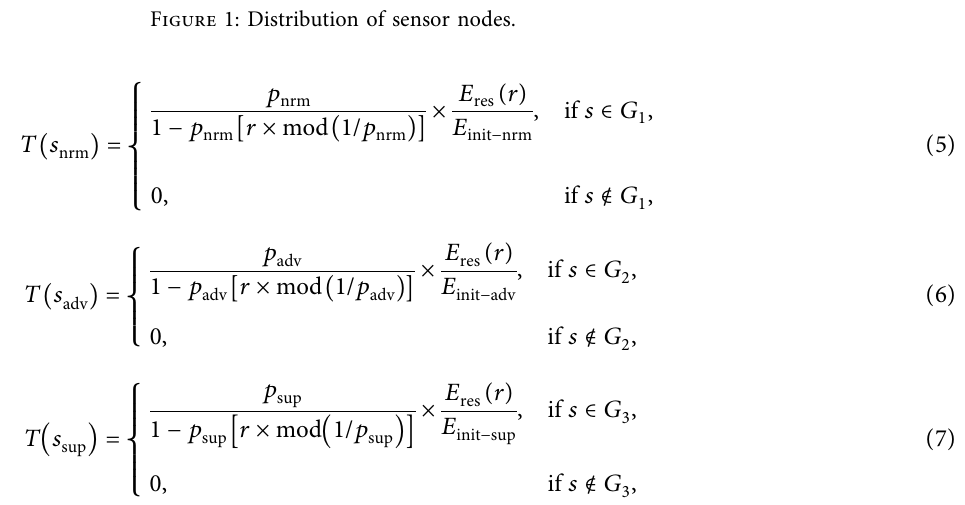
Figure 1: Distribution of sensor